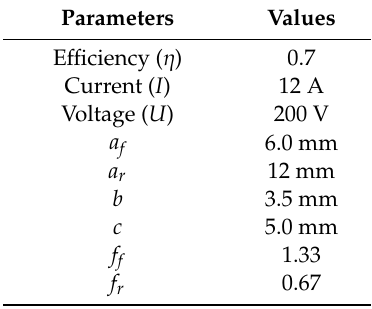
Table 2. Heat source parameters for the FE